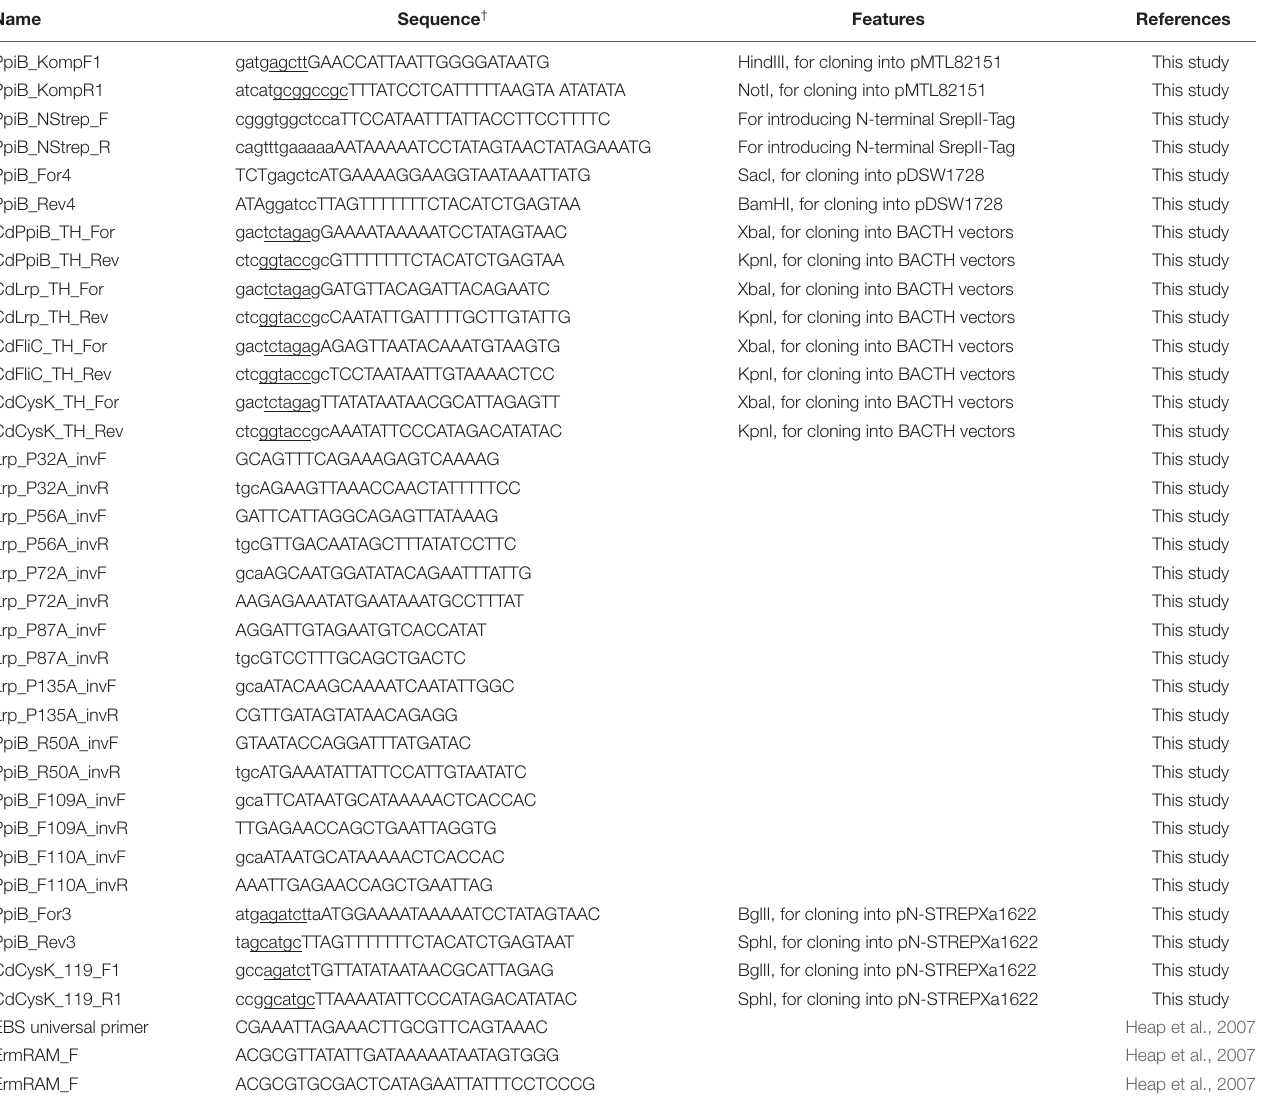
TABLE 2 | Primers used in this